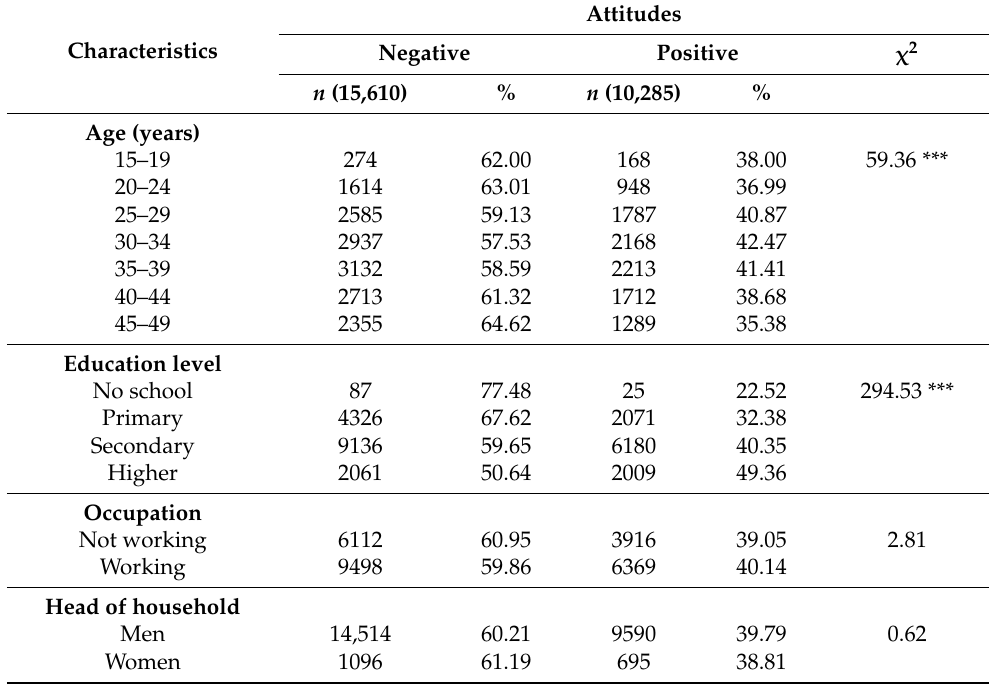
Table 3. Socioeconomic and demographic information and attitudes toward HIV/AIDS among women aged 15–49 years old in